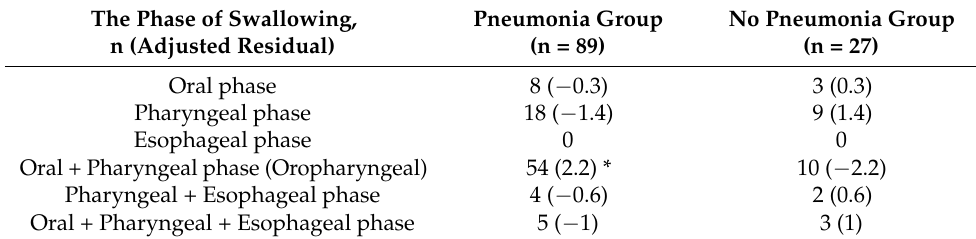
Table 5. Post hoc testing between